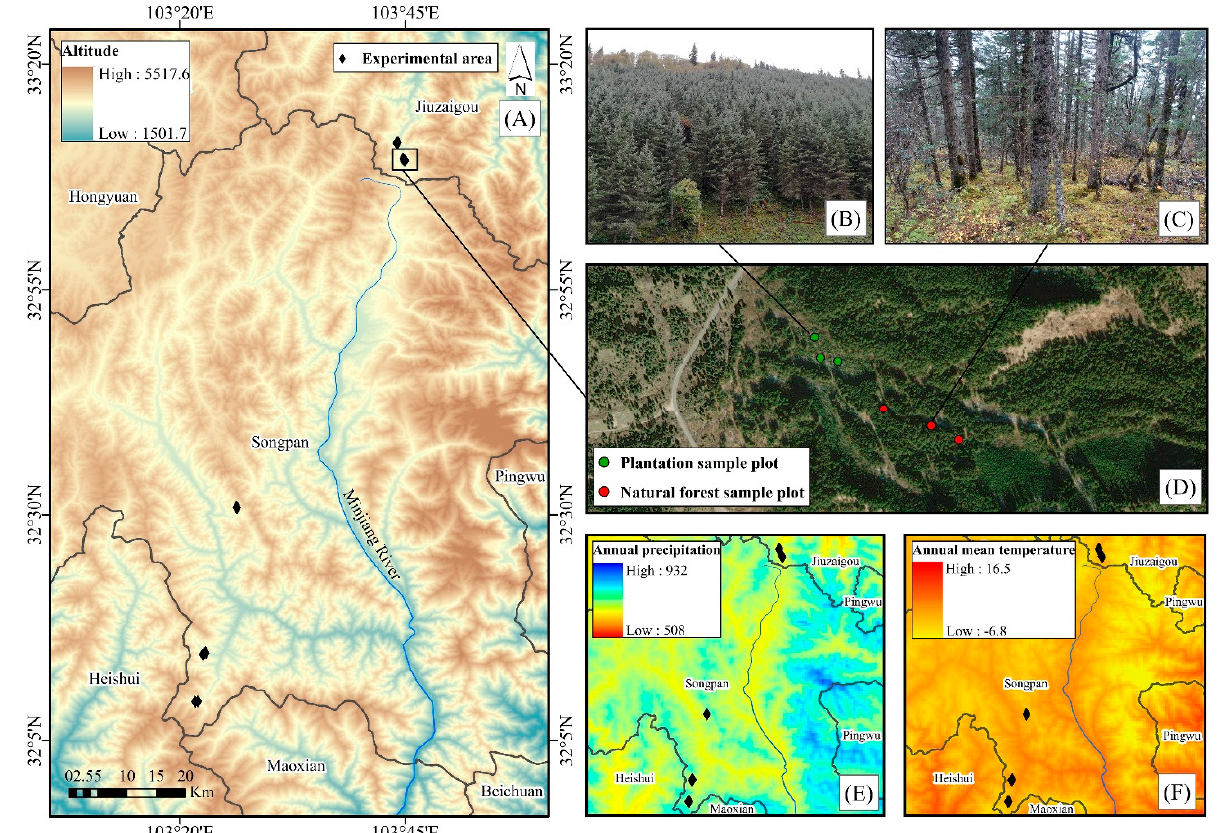
Figure 1. Location and general information of sampling sites in the Songpan and Jiuzhaigou counties in western Sichuan Province of China. ( A ): locations of the five experimental areas containing both the spruce plantation and adjacent natural forest; ( B ): plantation photograph; ( C ): natural forest photograph; ( D ): 20 m × 20 m sample plots with three replicates in plantation and natural forest; ( E ): diagram of annual precipitation; ( F ): diagram of annual mean temperature in the study area. The mean annual precipitation and temperature layer were found using the online resources https://worldclim.org/, accessed on 15 March 2022.